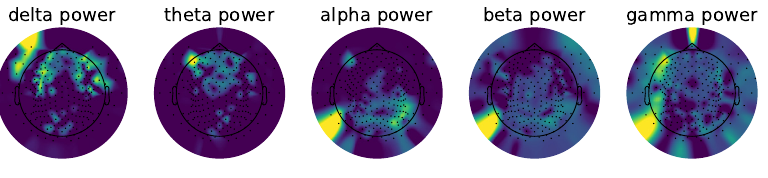
Figure 5. Power activity in the δ , θ , α , and β bands for participant s299392 exposed to guided imagery.